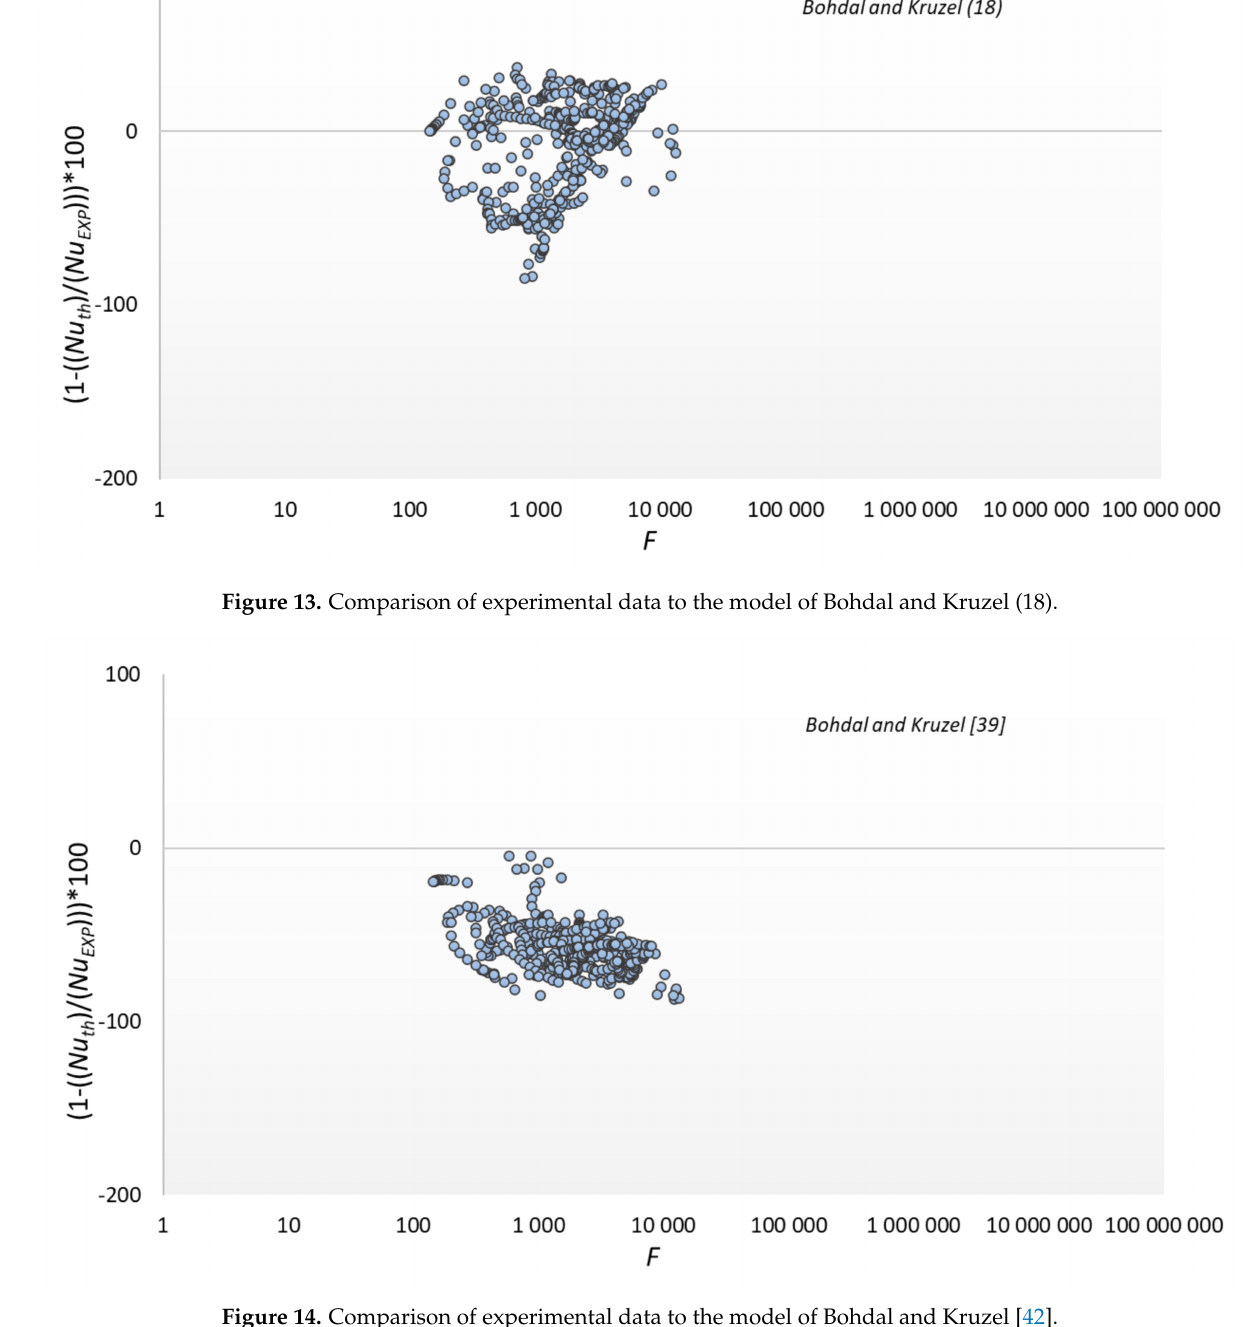
Figure 14. Comparison of experimental data to the model of Bohdal and Kruzel